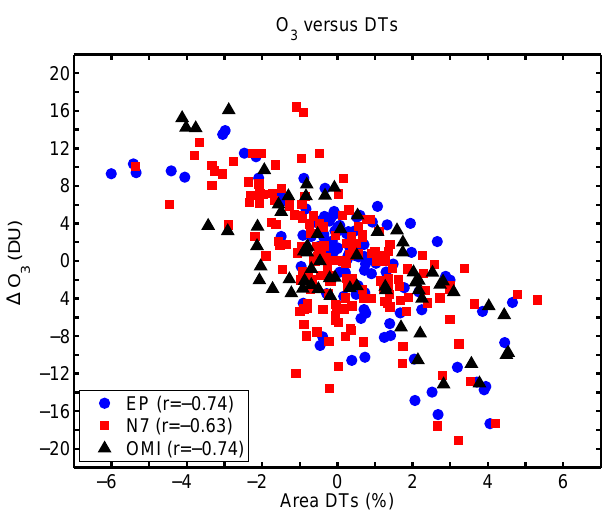
Fig. 4. As in Fig. 3 but with column ozone from ERA Interim re- analysis (1979–2010). A 5-yr running mean was removed from both Fig.4. AsinFig. 3butwithcolumnozonefromERAInterimreanalysis(1979–2010). A5-yearrunningmean wasremovedfrombothtimeseries. Thecorrelationisstatisticalsignificantatthe99%level(seethetext). time series. The correlation is statistical significant at the 99% level (see the